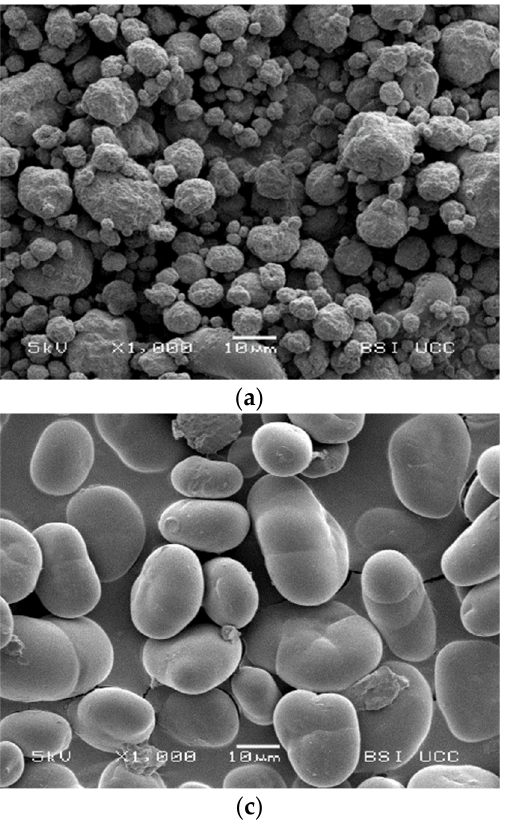
Figure 5. Scanning electron microscopy (SEM) pictures of the examined faba bean fractions: ( a ) PI 1, magnification factor = 1000; ( b ) PI 2, magnification factor = 1000; ( c ) SF, magnification factor = 1000; ( d ) FRF, magnification factor = 1000.